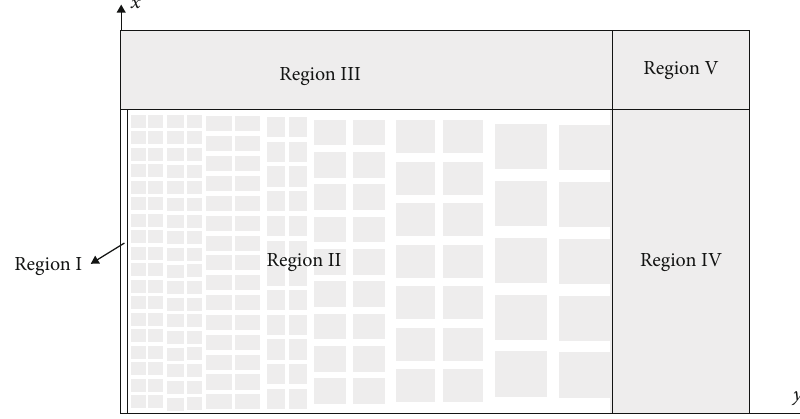
Figure 1: Schematic diagram of single-fracture fl ow